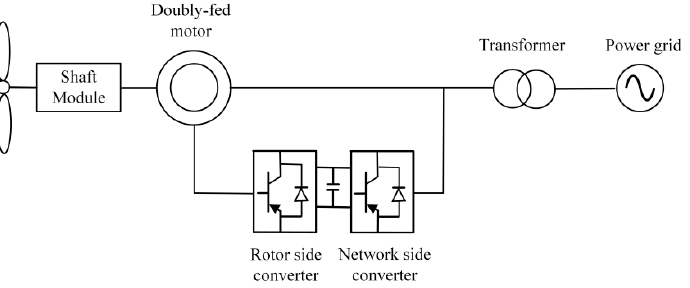
Figure 9. Schematic diagram of the doubly-fed wind power generation system.